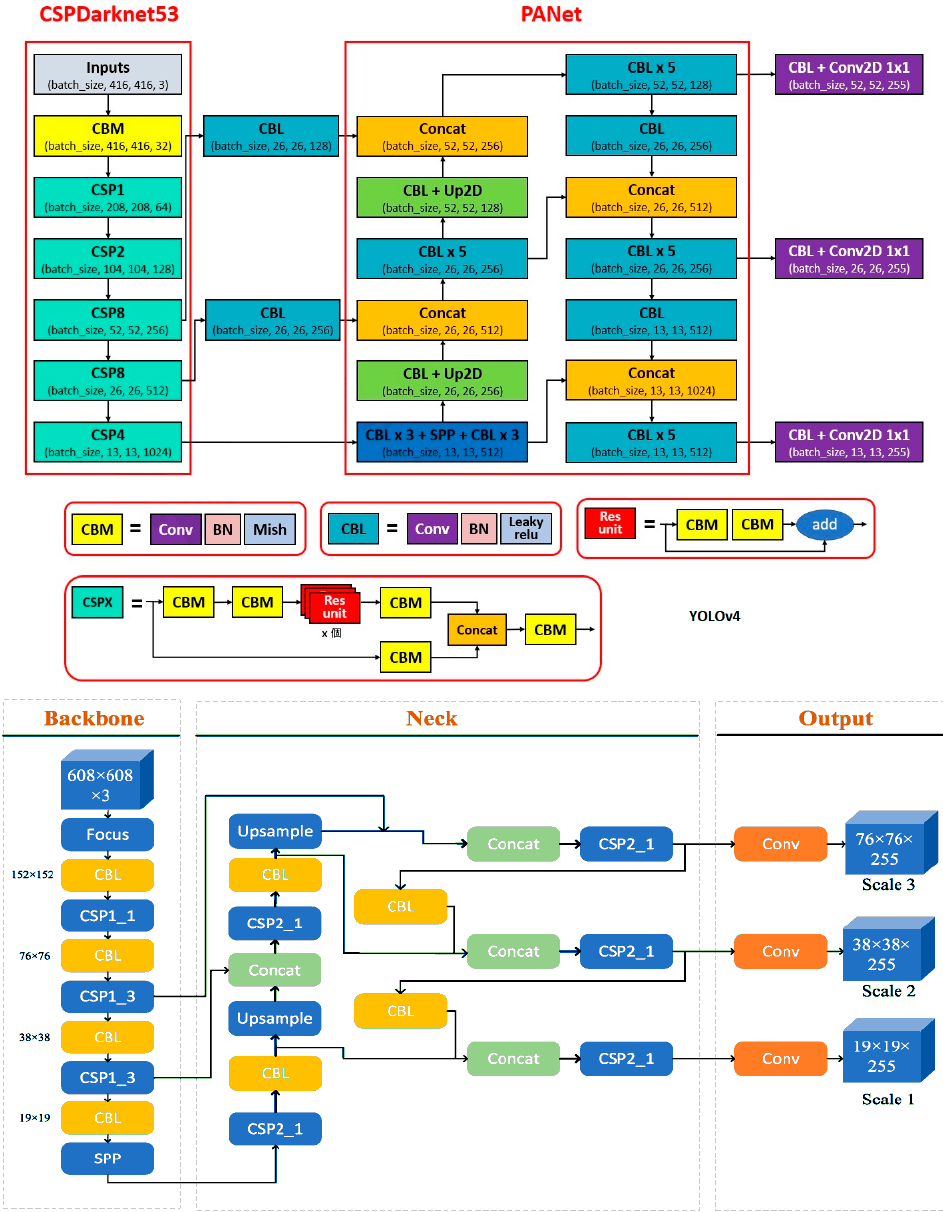
Figure 3. Yolov4 and Yolov5 architectures.